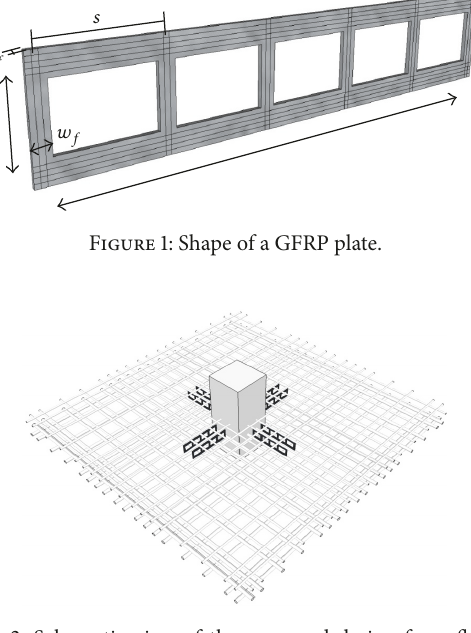
Figure 2: Schematic view of the proposed design for a flat plate reinforced with GFRP plates.